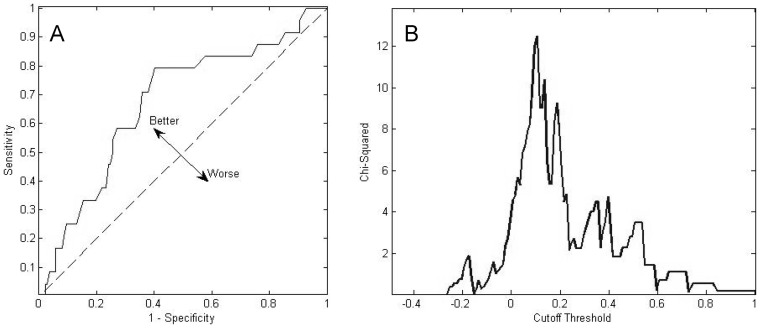
A: ROC plot of COP displacement variable.Sensitivity and 1-Specificity are plotted as the cutoff value is varied. The ideal location is in the upper left hand quadrant (1,0), where 100% of fallers are detected and 0% of non-fallers are identified (no false positives). The dotted line (line of no-discrimination) represents the location of a value with no predictive value (catches the same percentage of both fallers and non-fallers). B: Plot of chi squared value versus cutoff threshold. Values over 3.84 have a significance of p<0.05, and values over 10.83 have significance of p<0.001. Data from other variables result in similar values.